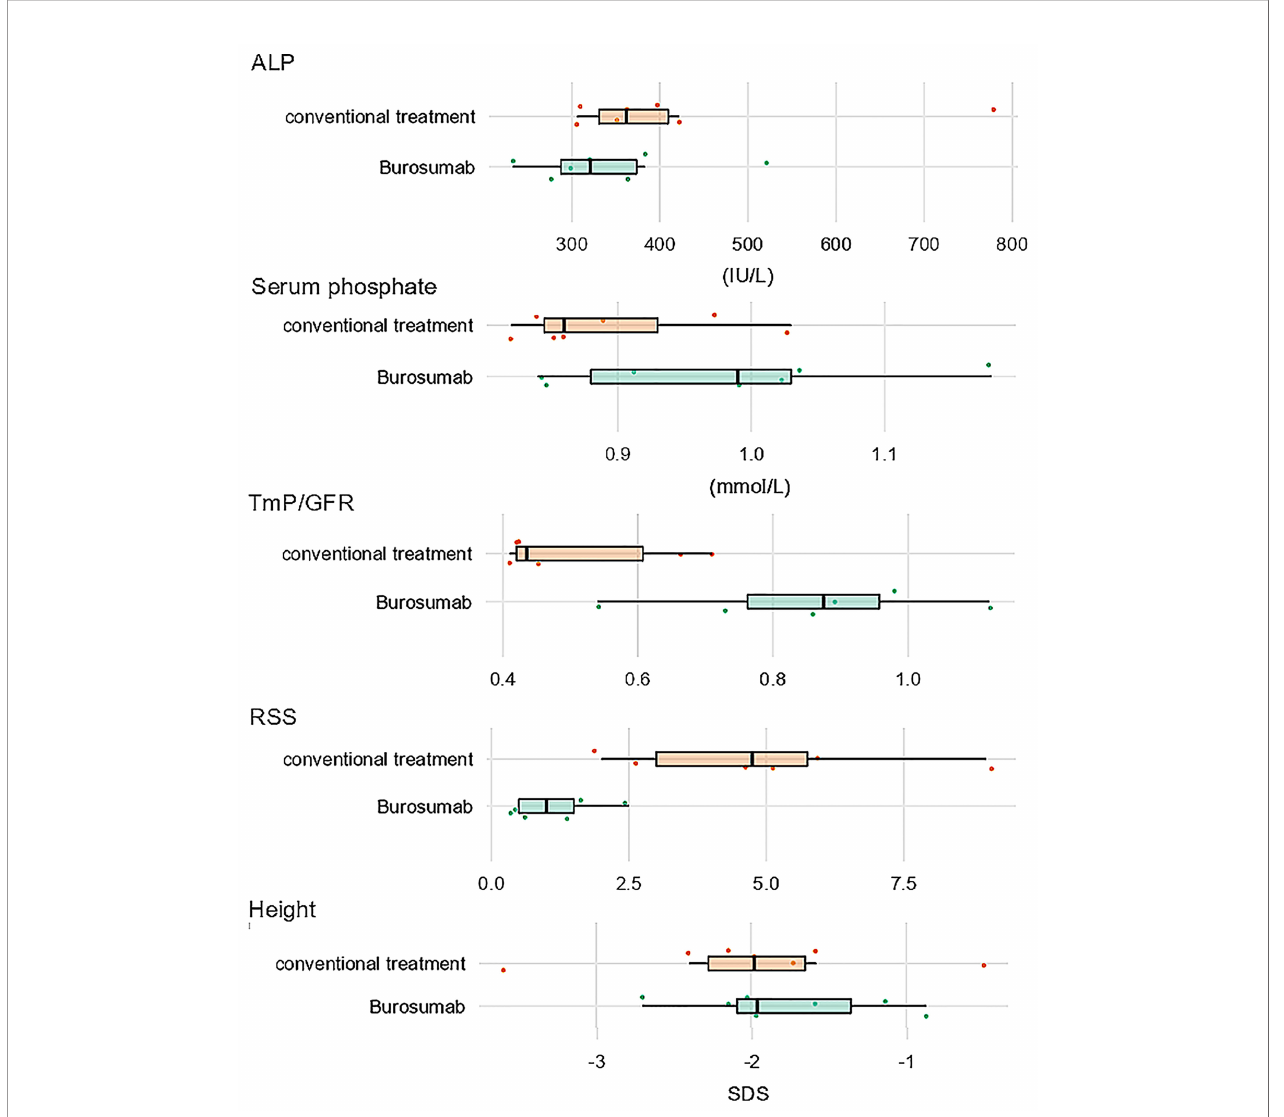
FIGURE 1 | Box plot chart of biochemical, radiographic, and anthropometric markers of treatment response in XLH under conventional treatment (orange) and one year after switch to Burosumab treatment (green). Boxes show median values, upper and lower